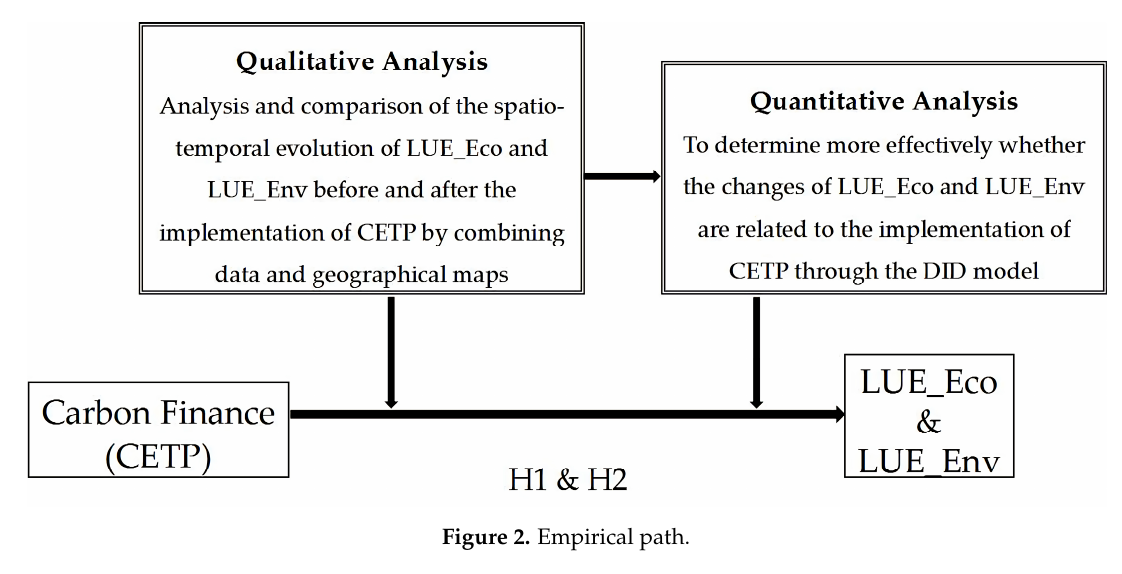
Figure 2. Empirical path.